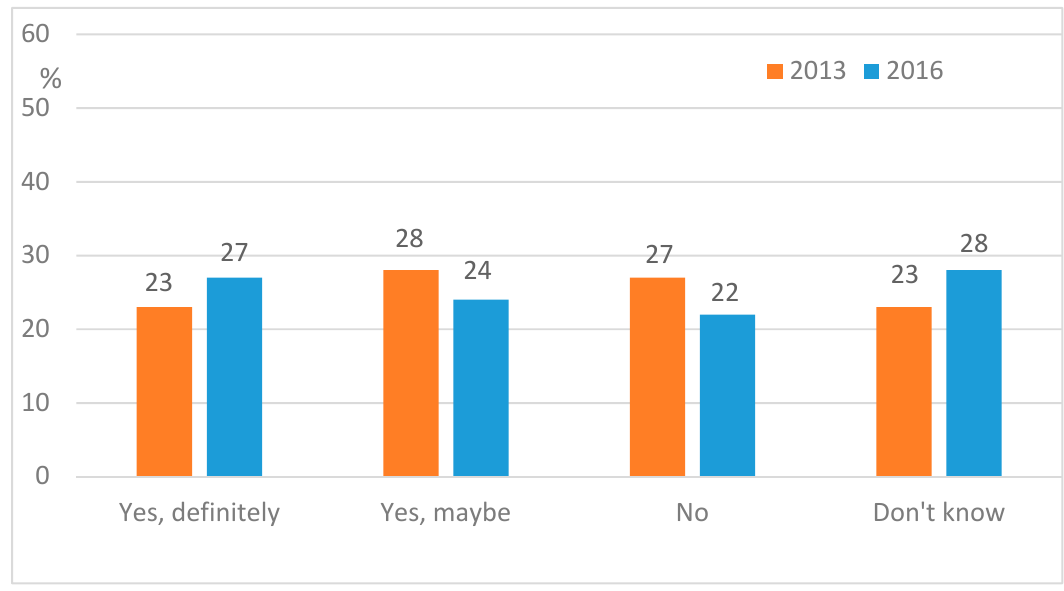
Figure 9. Question just to the MPs: Do you think nuclear waste should be disposed in a manner that allows it to be readmitted, for example to be reused in new types of nuclear